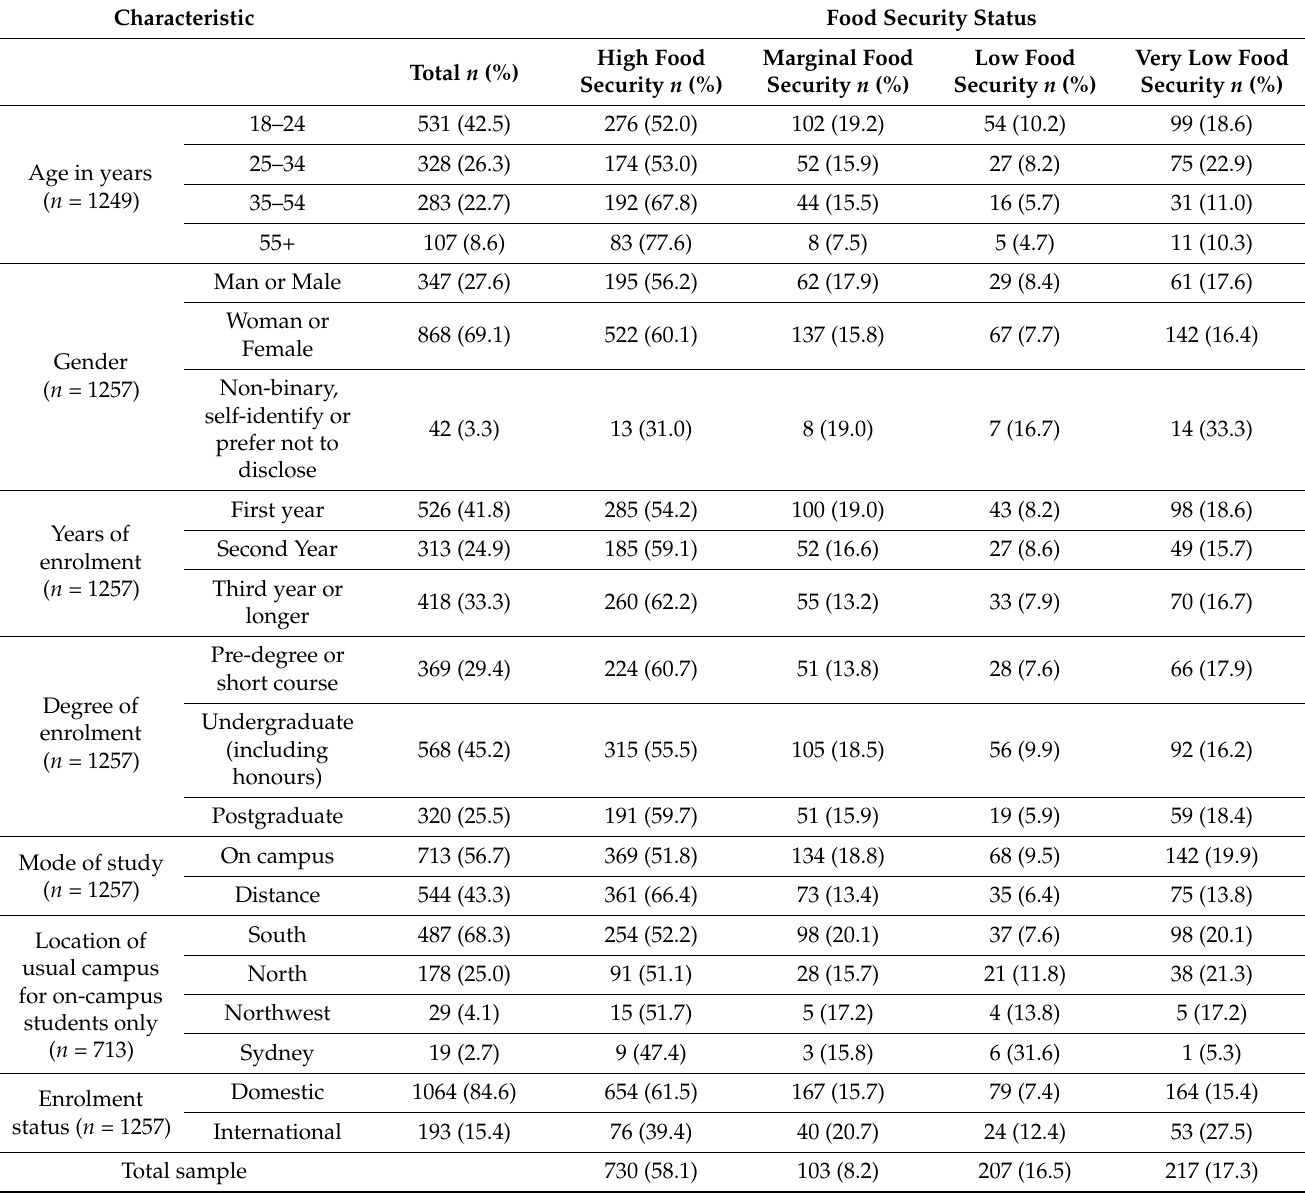
Table 1. Food Security Status of the sample of university students according to demographic and education